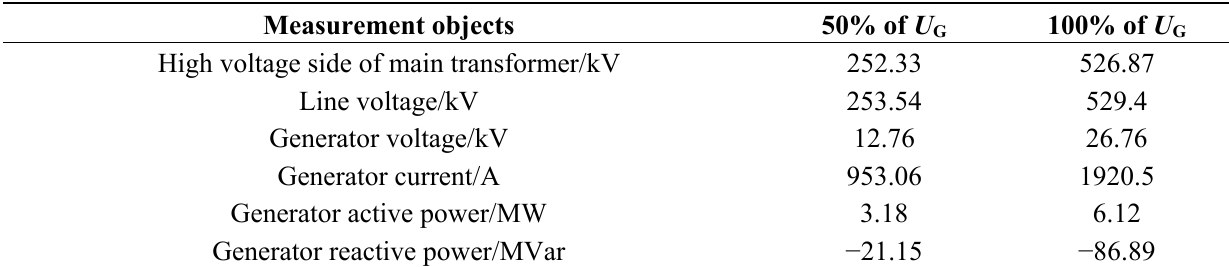
Table 3. Measured data of the raising voltage from zero test.